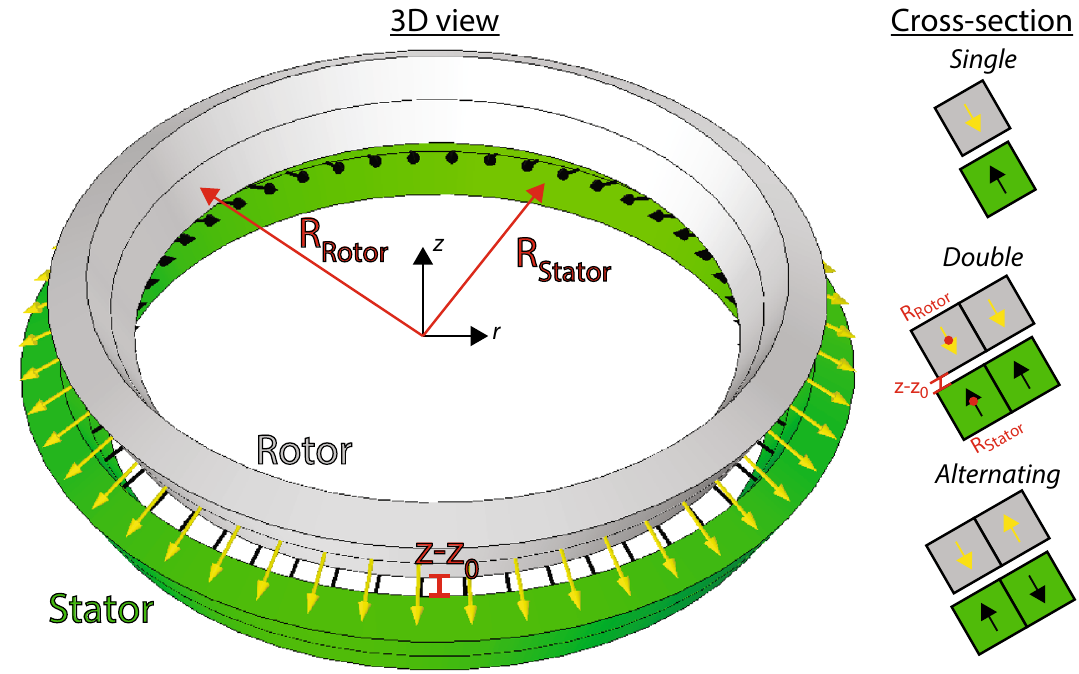
Figure 1. The bearing geometry considered. The stator, shown in green, and the rotor, shown in grey, each consists of two tilted rings of permanent magnets with a quadratic cross-section. The rotor has an inwards magnetization normal to the surface of the rings, while the stator has an outwards magnetization, as indicated by the arrows. The radii R rotor and R stator , which are the radius to the center of the lower ring in either, is also indicated, as is z − z 0 . The rotor is displaced along the z -axis. The bearing illustrated here has a tilt angle of 30 ◦ , as also illustrated in Fig. 2. On the right is shown a cross-section of the bearing, with the three types of magnet configurations considered, as explained in the text. The geometry illustrated on the left is the double bearing.